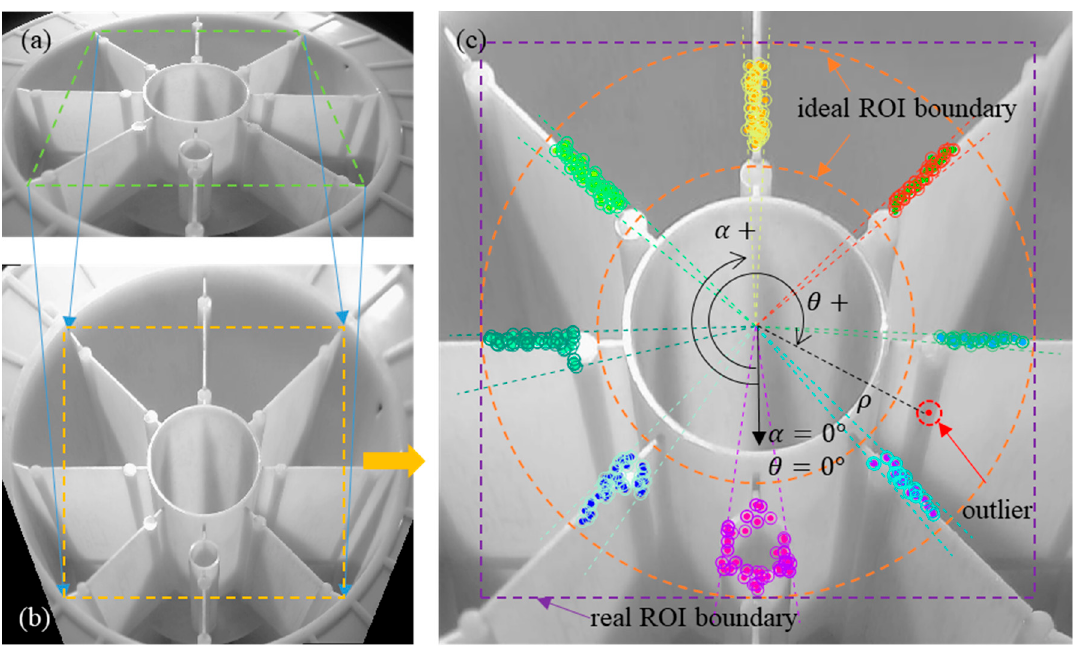
Figure 6. Image pre-processing and FPDD: ( a ) original captured image, ( b ) perspective transform and the ROI, ( c ) the FPDD strategy. Points with same color are clustered into one group, and the isolated red point is recognized as outlier.